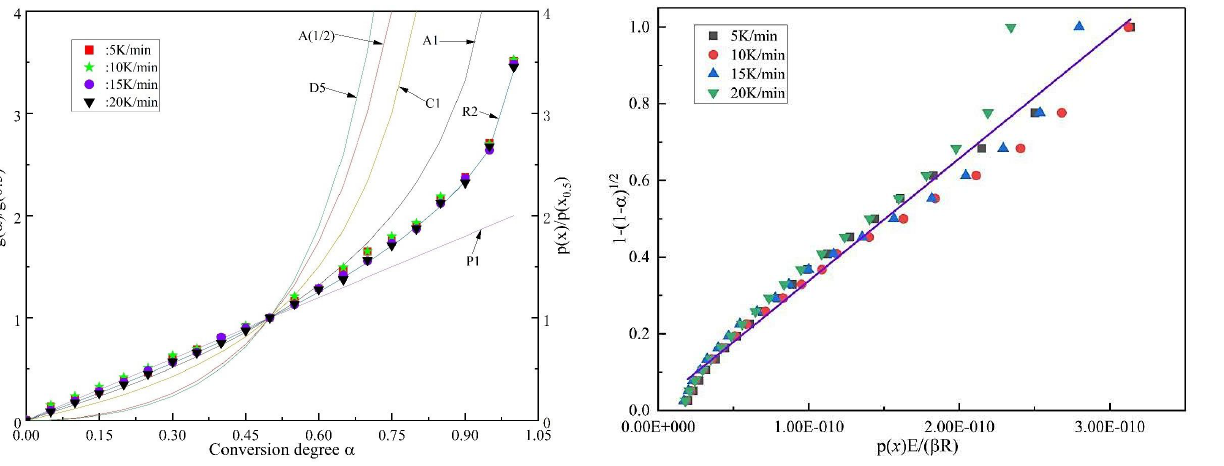
Figure 6: Plotting 1 − (1 − α ) 1/2 vs p ( x ) E /( βR ) at different heating rates and their linear-fitting (solid line) tion of phosphate rock with particle sizes 38-48 µm, 75– 100 µm, and 100-150 µm were calculated. The results were summarized in the Table 5.